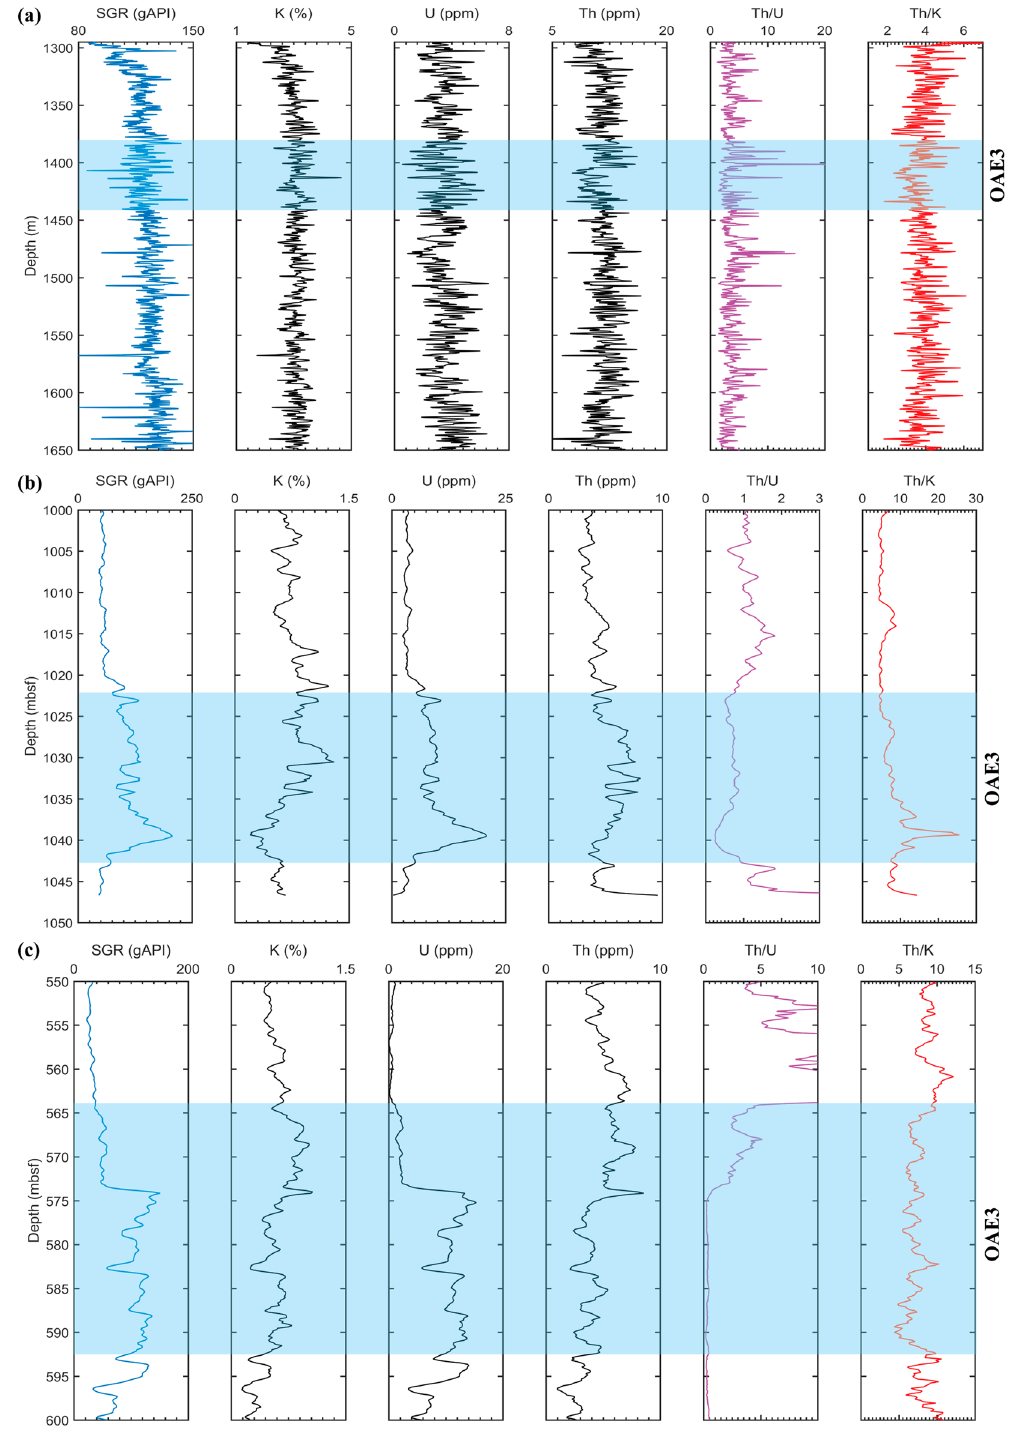
Figure 9. Spectral gamma ray, the computed Th/U and Th/K ratios, and the studied Coniacian–Santonian OAE intervals in SK1S ( a ), 959D ( b ) and 1261B ( c ). The OAE3 intervals in SK1S, DIB and DR are from Jones et al. 23 , Wegner et al. 98 and Beckmann et al. 20 ,